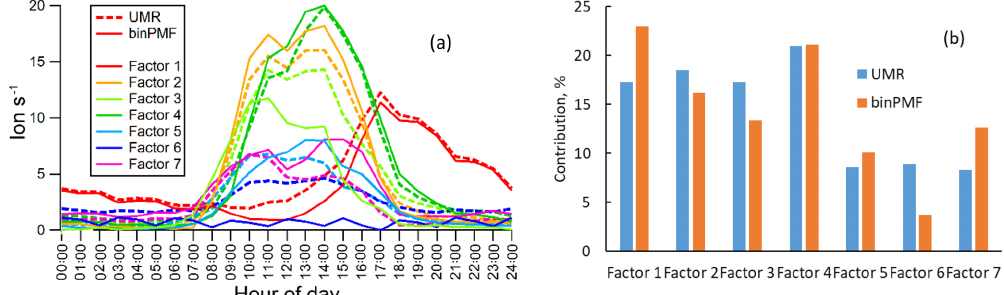
Figure 8. Comparison of binPMF and UMR-PMF for (a) diurnal trend and (b) factor contribution.